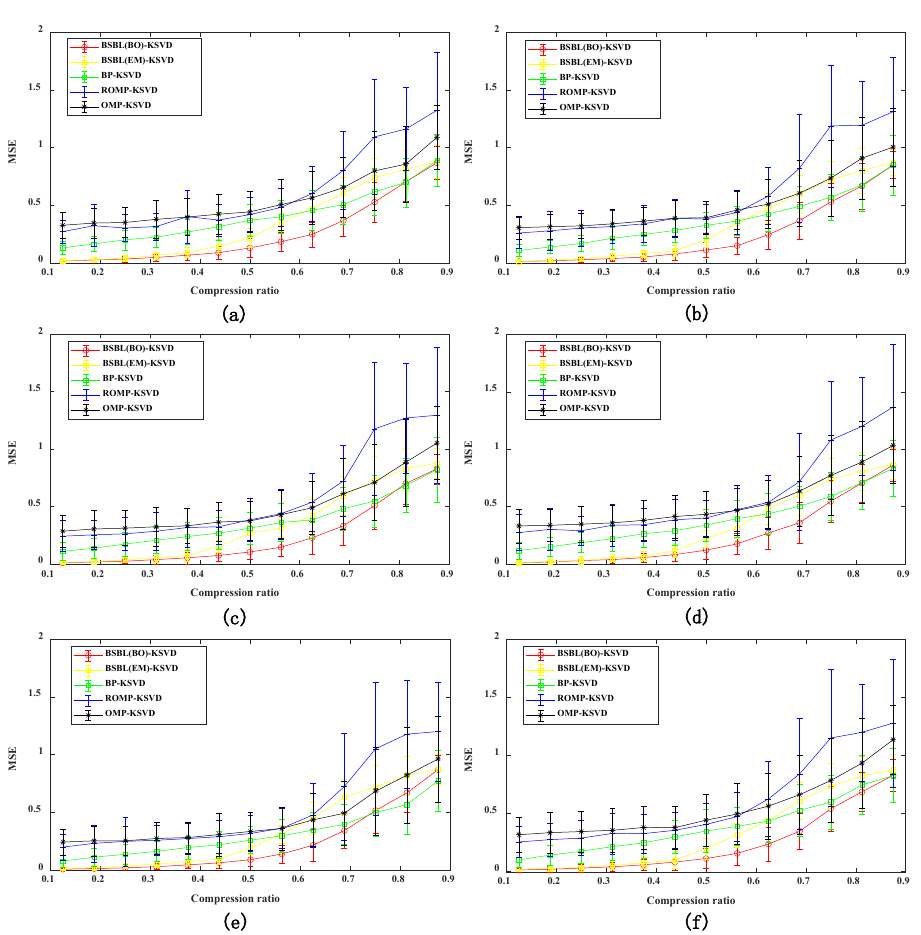
Figure 5. Comparative analysis of MSE 95% confidence intervals of six datasets: ( a )